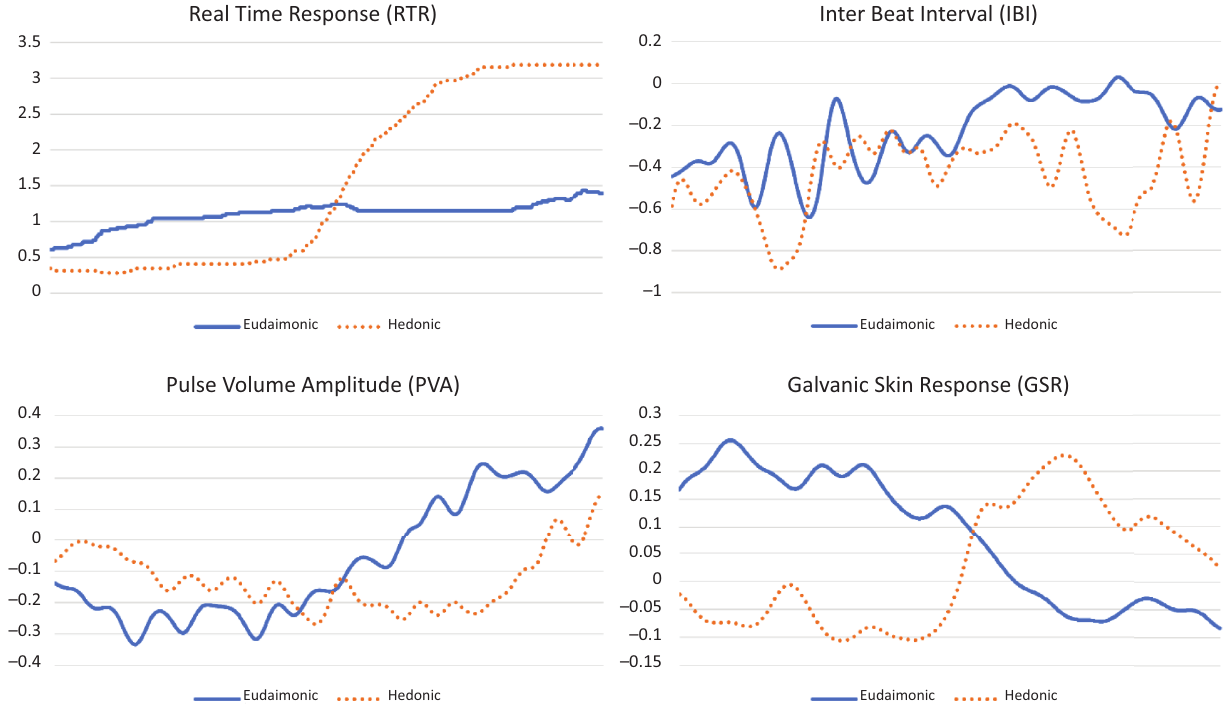
Figure 4. Time series means for the four process measures during the 15 seconds before and after the end of the fight between